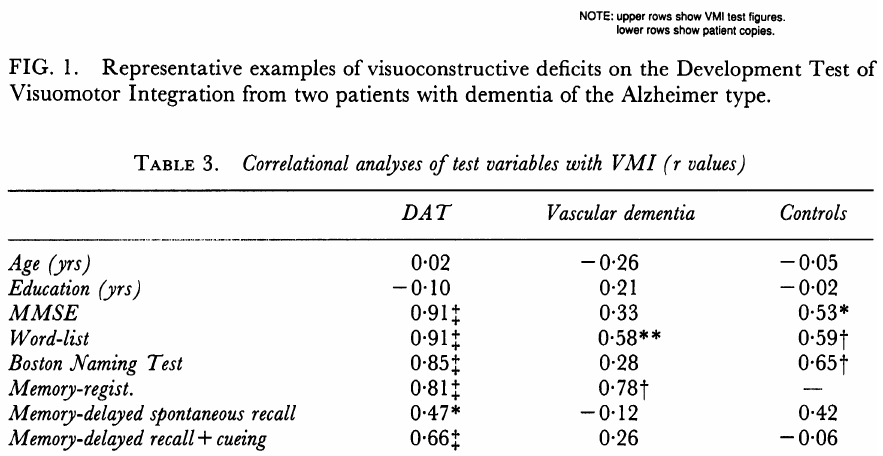
NOTE: upper rows show VMllest figures. lower rows show patient copies.